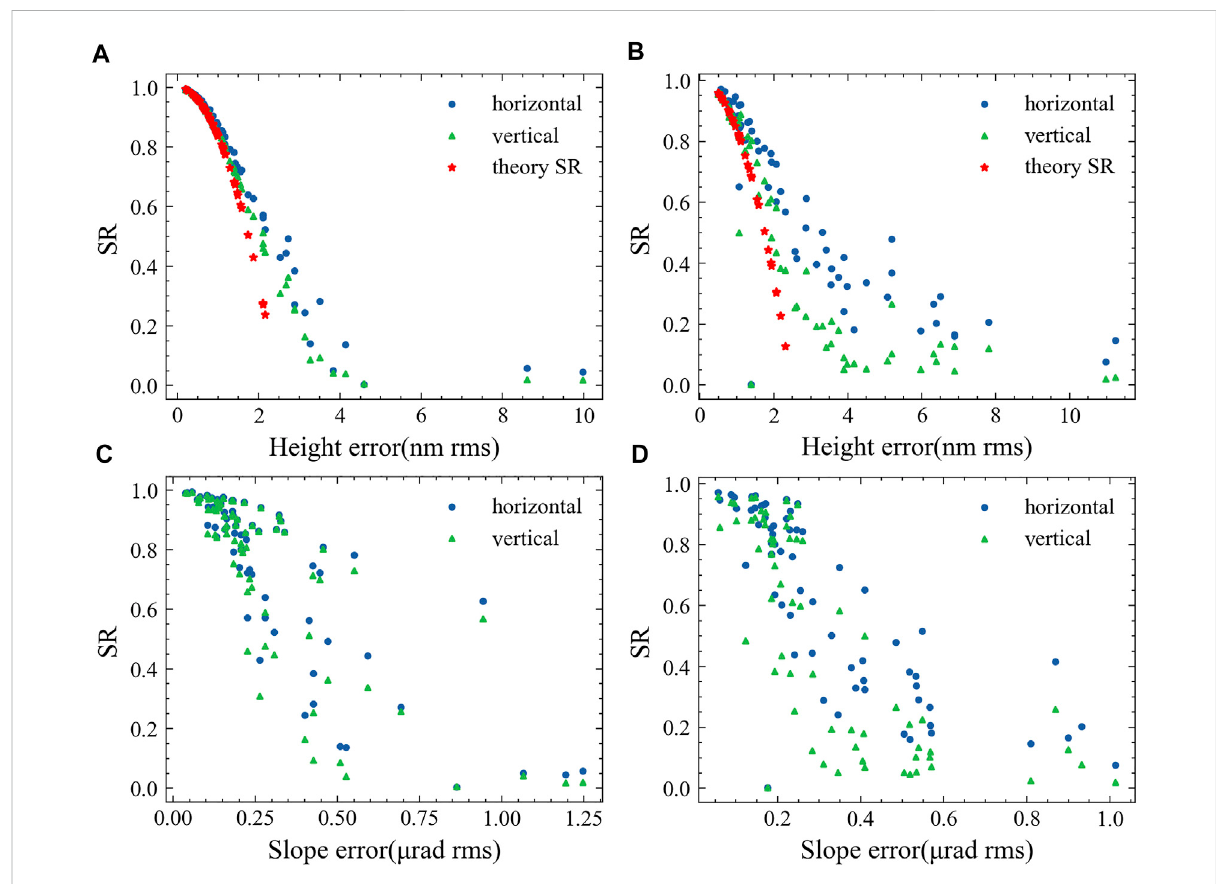
FIGURE 11 SRforOpticalSimulation. (A) istheheighterror-SRscatterplotfor10 μ rad acceptanceangle, (B) istheheighterror-SRscatterplotfor18 μ rad acceptance angle, (C) is the slope error - SR scatter plot for 10 μ rad acceptance angle, (D) is the slope error - SR scatter plot for 18 μ rad acceptance angle.